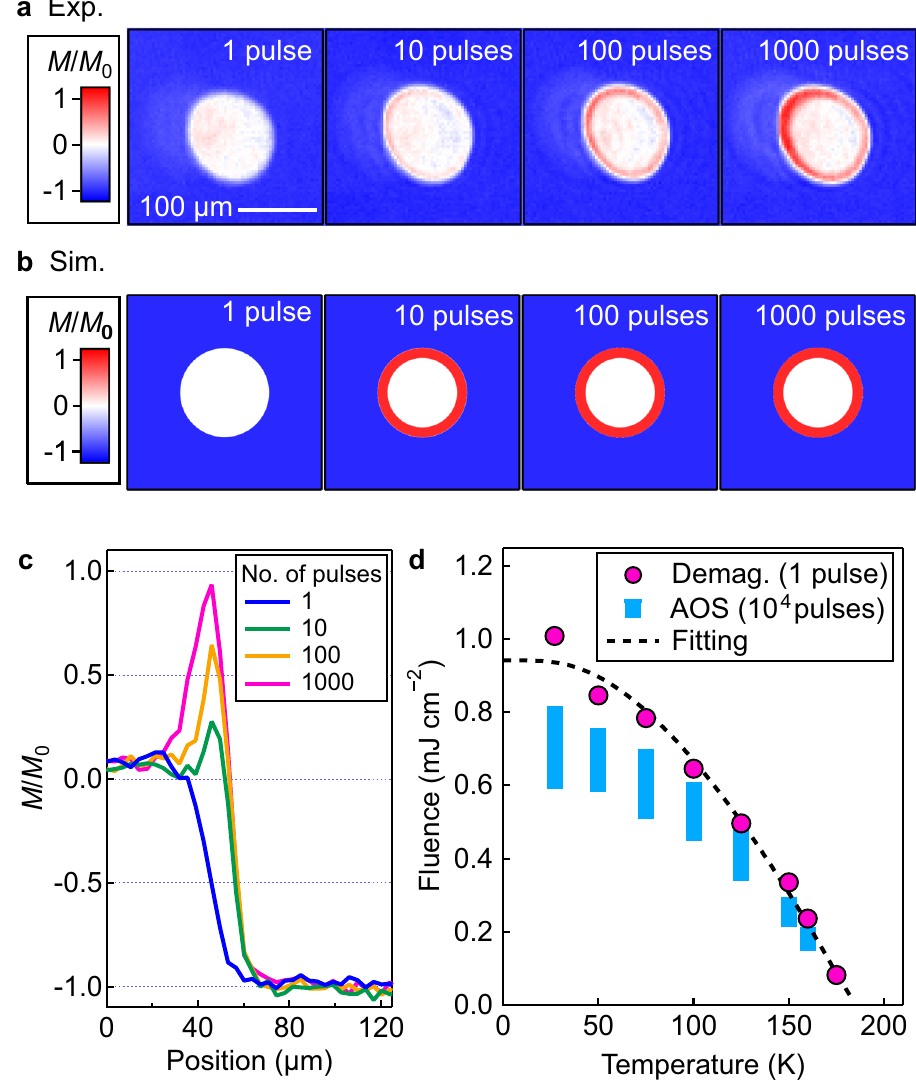
Fig. 4 Pulse-to-pulse accumulation effect of light-induced magnetization switching. a Magnetization images of initially saturated fi lm at 100 K after exposure to 1, 10, 100, and 1000 pulses of σ þ polarized mid-infrared (MIR) light with a fl uence of 1.26 mJ cm − 2 . The color scale indicates the magnetization at each position M divided by the saturated value M 0 , therefore M = M 0 = − 1( + 1) corresponds to the spin down (up) state. b Simulated magnetization images with single-pulse and multiple (10 4 )-pulse excitations. c Line pro fi les of the magnetization from the central area and across the outer ring region depicted by images in ( a ). d Minimum laser fl uence required to demagnetize the sample at the beam center by a single-pulse excitation (magenta circle). Dashed line represents the fi tting curve describing the energy required to heat the sample to T C . Blue bars show the range of fl uence where magnetization reversal is observed after 10 4 -pulse